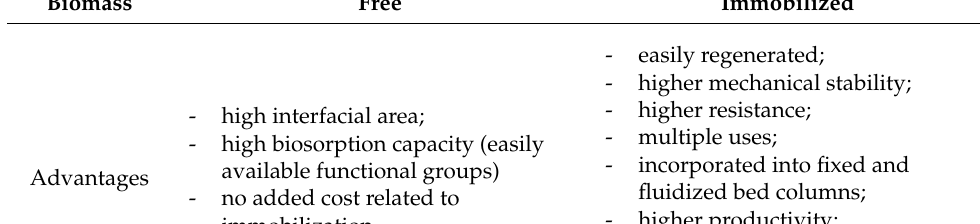
Table 1. Advantages and disadvantages of free and immobilized biomass used as biosorbent [23,27] Biomass